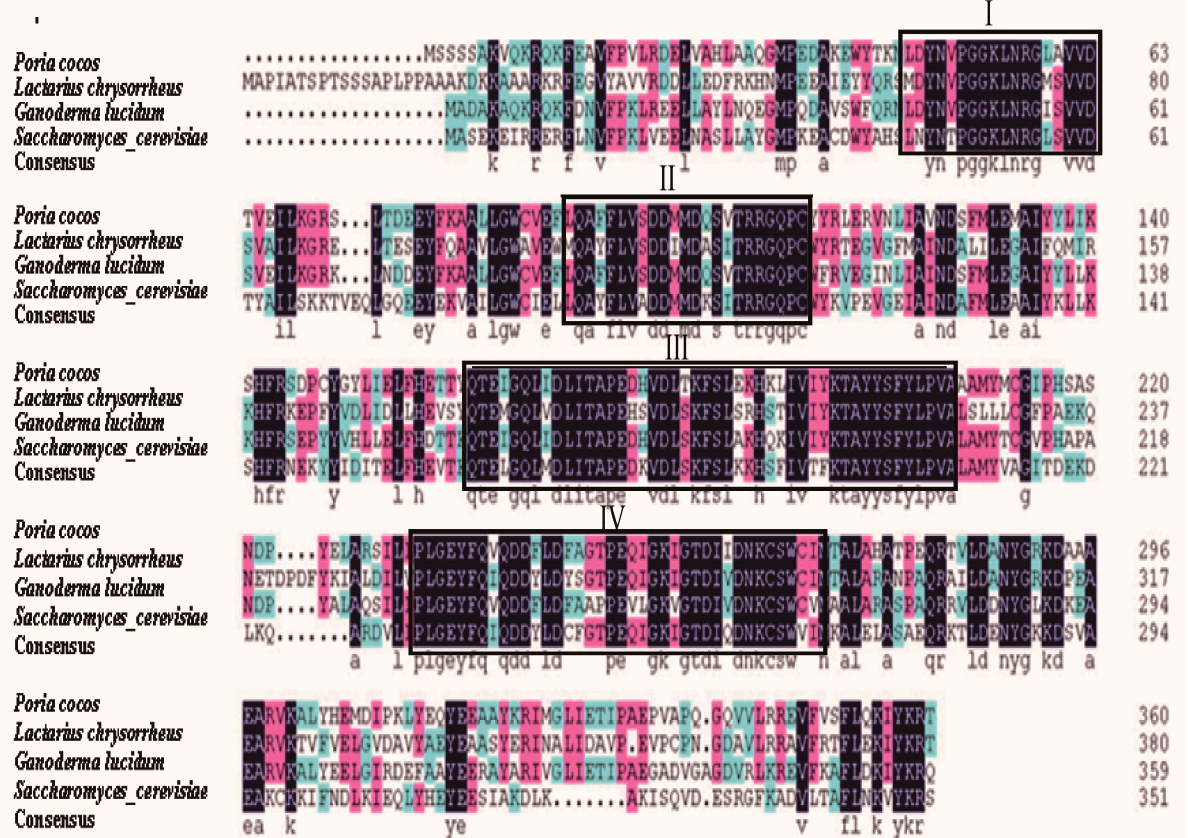
Figure 3. Sequences of other fungal species were obtained from the GenBank (